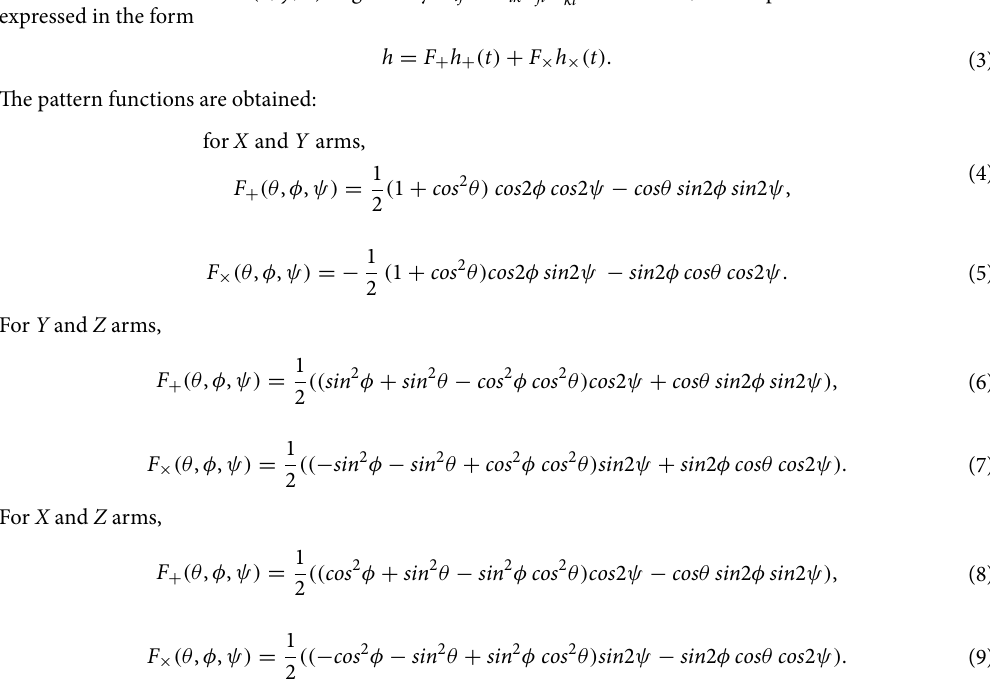
′ kl . As a result, the response function h can be